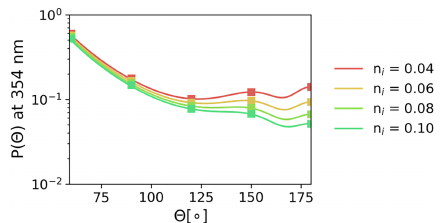
Figure A3. Phase function P((cid:50)) at 354nm of the parameterized Mie-scattering aerosol in sensitivity studies as a function of n i (with r g = 0 . 15µm and n r = 1 . 5). The markers in the plot correspond to values when (cid:50) = 60, 90, 120, 150, 180 ◦